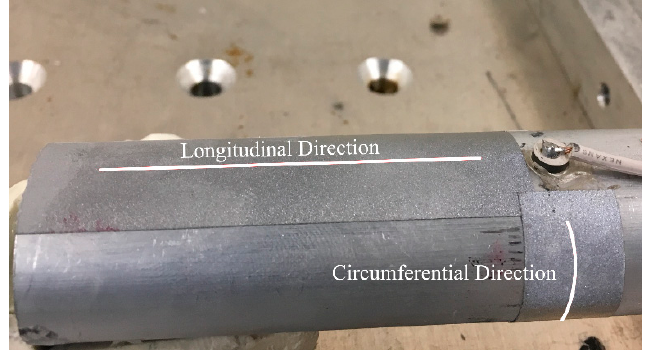
Figure 6. Image of oval surrogate bone with showing the longitudinal and circumferential scan line.